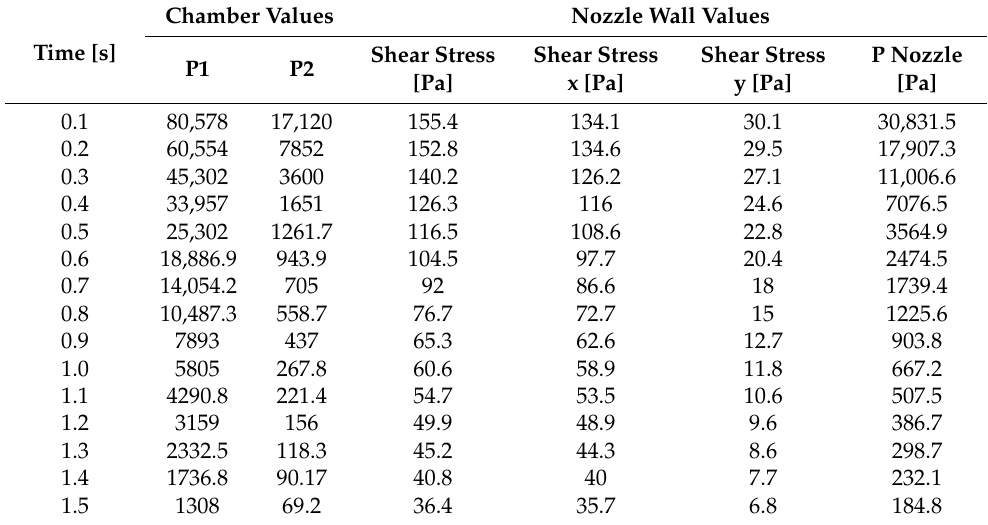
Table 2. Values of monitored variables during chamber pumping.